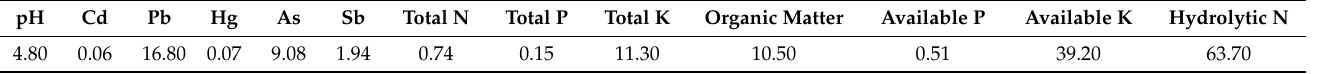
Table 1. Background chemistry of potted soil (units mg/kg